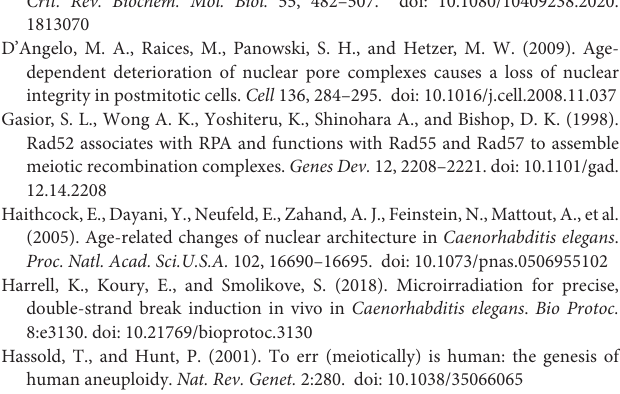
Supplementary Figure 1 | RAD-51 staining in dissected germ lines from spo-11(ok79) mutants at 1 and 4 days post-L4. DNA is visualized with DAPI (green); RAD-51 with anti-RAD-51 antibodies (Magenta). Shown are maximum projection images through half of the germ line. Almost no RAD-51 foci were observed in germ lines from day 1 adults; approximately half of day 4 adult germ line pachytene nuclei had a single RAD-51 focus. Supplementary Figure 2 | GFP::RPA-1 levels are not diminished in aging C. elegans germline nuclei. (A) Representative images of pachytene nuclei from each age of worms examined expressing the endogenously- tagged GFP::RPA-1 fusion protein. Scale bars are 3 µ m. (B) Western blot analysis of RPA-1 protein in 1 day-old and 4 day-old adults. OLLAS::RPA-1 fusion proteins were detected with anti-OLLAS antibodies. Tubulin serves as loading control. (C–E) Average intensity of GFP::RPA-1 in meiotic nuclei, corrected for cytoplasmic background. Each point indicates a single nucleus, error bars indicate the Standard Error of the Mean. (C) Pre-meiotic phase nuclei. (D) Transition zone (polarized chromatin, leptotene/zygotene phases) nuclei. (E) Mid- and late-pachytene phase nuclei. Statistical significance was determined using the Mann-Whitney U -test and p -values are indicated as follows: ns ≥ 0.1234, 0.0332–0.1233 = ∗ 0.0021–0.0331 = ∗∗ 0.0002–0.0020 = ∗∗∗ ≤ 0.0001 = ∗∗∗∗ . Nuclei n -values as indicated for each condition. Supplementary Figure 3 | Percentage of middle pachytene (MP) nuclei containing the indicated number (key at far right) of GFP::RPA-1 foci (left) or RAD-51 foci (right) in spo-11 at timepoints post-10Gy of γ -irradiation. Numbers on top of bars indicate the total number of nuclei analyzed per age. A total of 10 worms per age/timepoint were analyzed. Statistical significance was determined using Chi-square test. ns p > 0.1, ∗ p < 0.05, ∗∗∗∗ p < 0.0001. Supplementary Figure 4 | Quantification of DAPI-bodies in cku-70 and polq-1 diakinesis nuclei from the indicated ages. Data analyzed in Figure 3 for N2 worms of the same ages was added to allow the comparison with the mutants. Numbers on top of bars indicate the total number of nuclei analyzed per